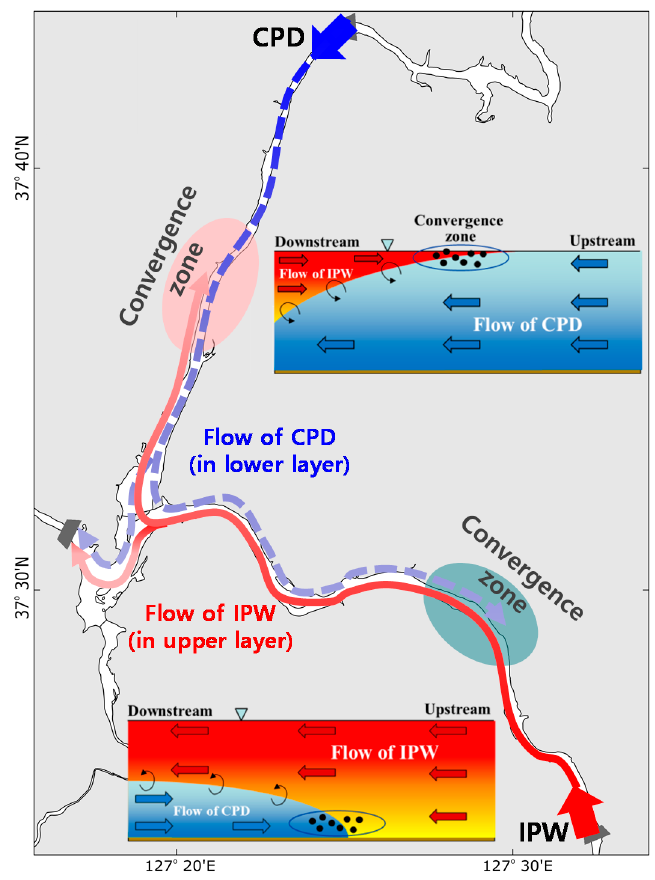
Figure 11. Diagram of the water circulation structure in the Paldang Reservoir (stratification period).